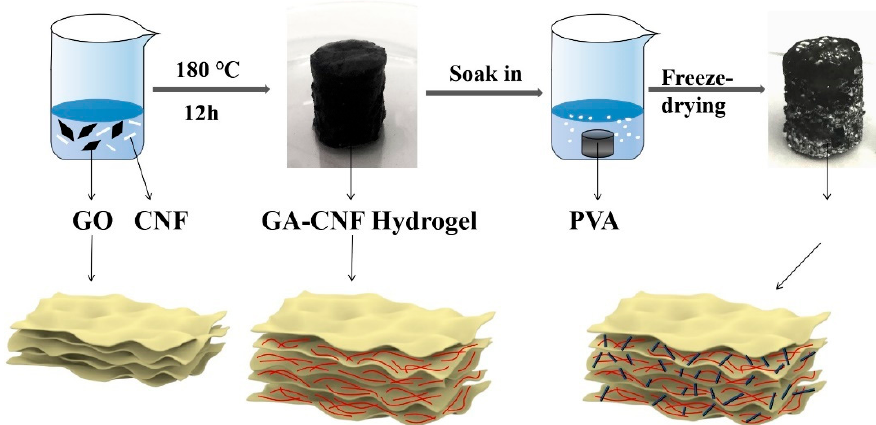
Figure 9. Preparation process of PVA ‐ GA ‐ CNF aerogels .